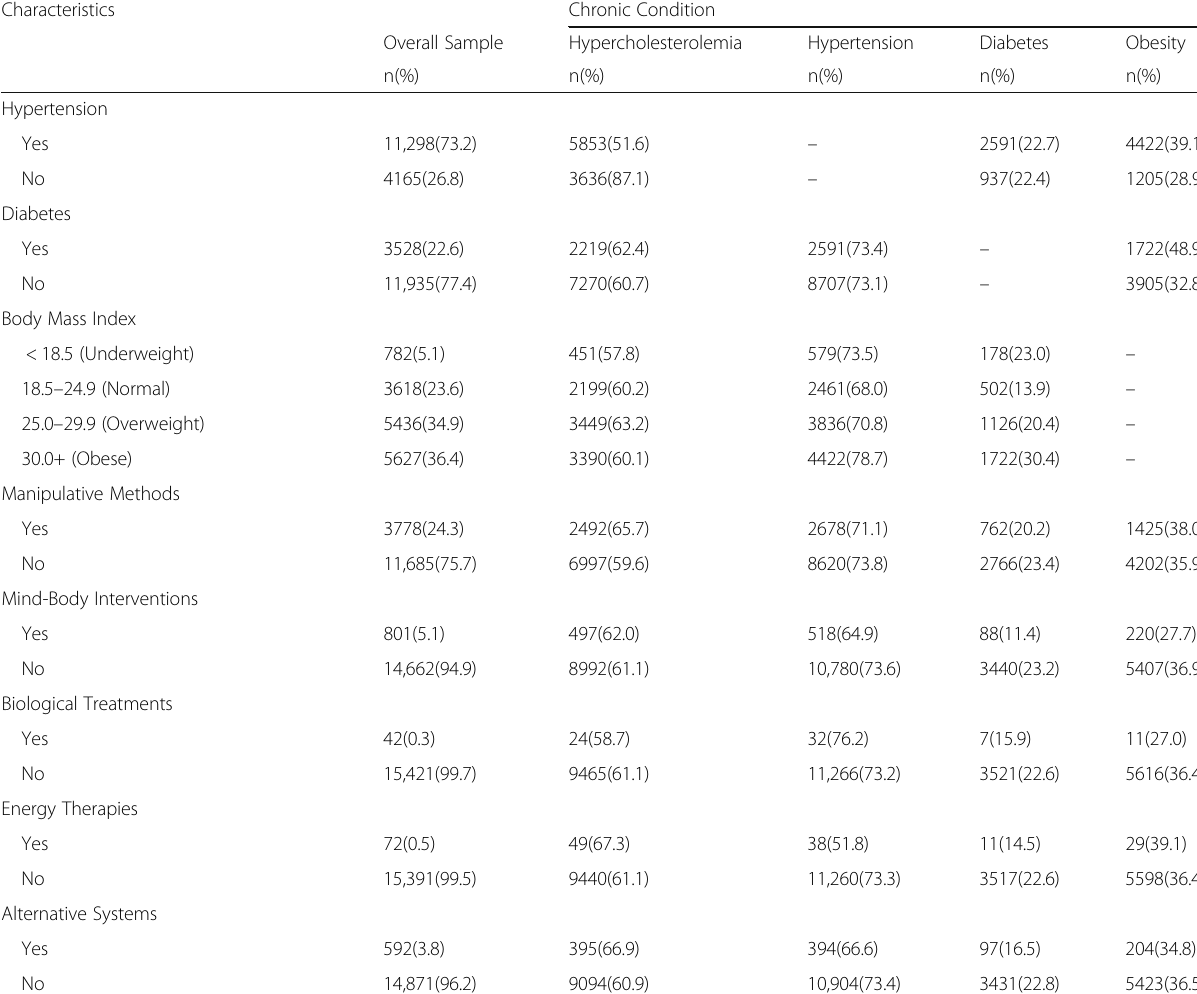
Table 1 Characteristics of the study sample and frequency of chronic conditions, national health interview survey, 2012 (Continued)